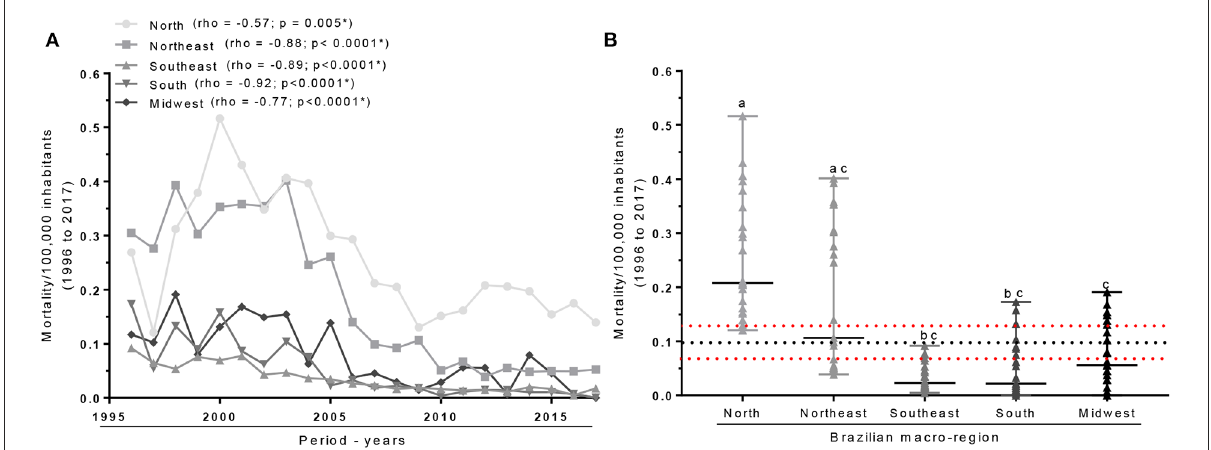
FIGURE1 Correlation and comparison of mean distributions of the prevalence of mortality from severe child malnutrition from 1996 to 2017 for the Brazilian macro-regions. (A) Temporal correlation between mortality per 100,000 inhabitants and the period of 22 years. (B) Comparison between the frequencies of mortality per 100,000 inhabitants for the different macro-regions. Spearman’s test was used to evaluate correlations and the Kruskal-Wallis test with Dunn’s multiple comparison post-test was used to compare distributions (median with range). Statistically significant differences were considered when p < 0.05. The * and the letters a, b, and c indicate statistically significant differences.